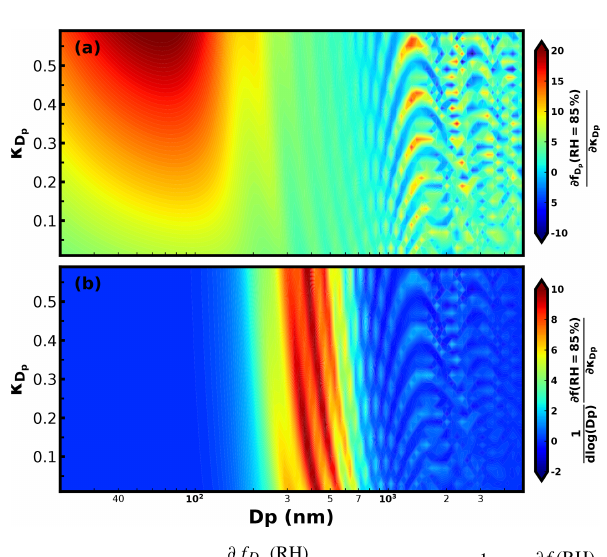
· ∂f( RH ) . ∂κ D p dlog D p